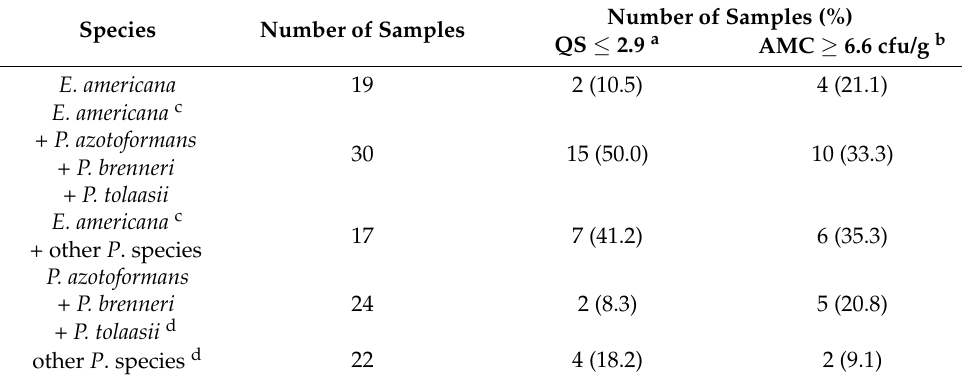
Table 3. Occurrence of Ewingella americana and Pseudomonadaceae relative to the sensory quality and aerobic mesophilic